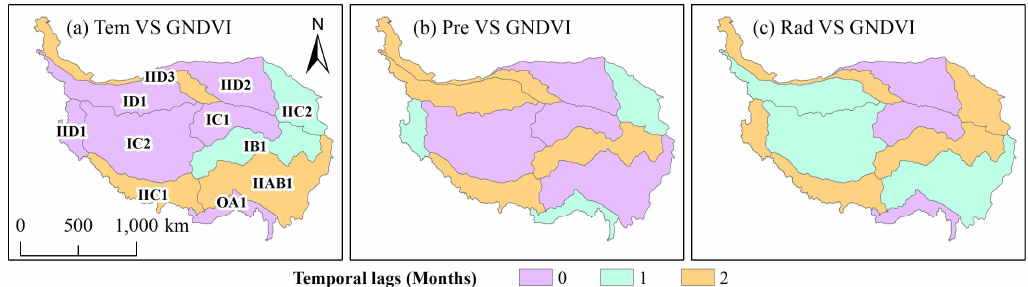
Figure 5. Climatic factors’ time lag at which the maximum partial correlation coefficient between GNDVI and ( a ) temperature (Tem), ( b ) total precipitation (Pre), and ( c ) radiation (Rad) across different ecosystem zones.